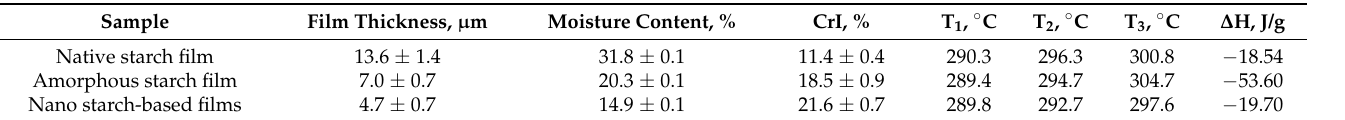
Table 2. Thickness, moisture, the crystallinity index, and thermal properties of native and nano starch-based films.